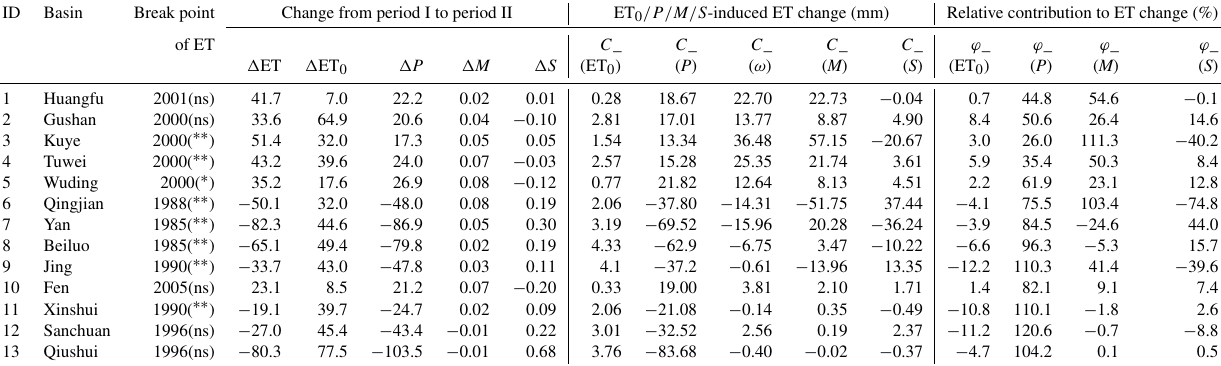
Table 4. Attribution analysis for ET changes for each basin. The relative contribution of a certain variable to the ET change ( ϕ(x)) was calculated as follows: ϕ(x) = (C _ (x)/(cid:49) ET ) × 100%, where C _( x ) represents the contribution of each variable. ID